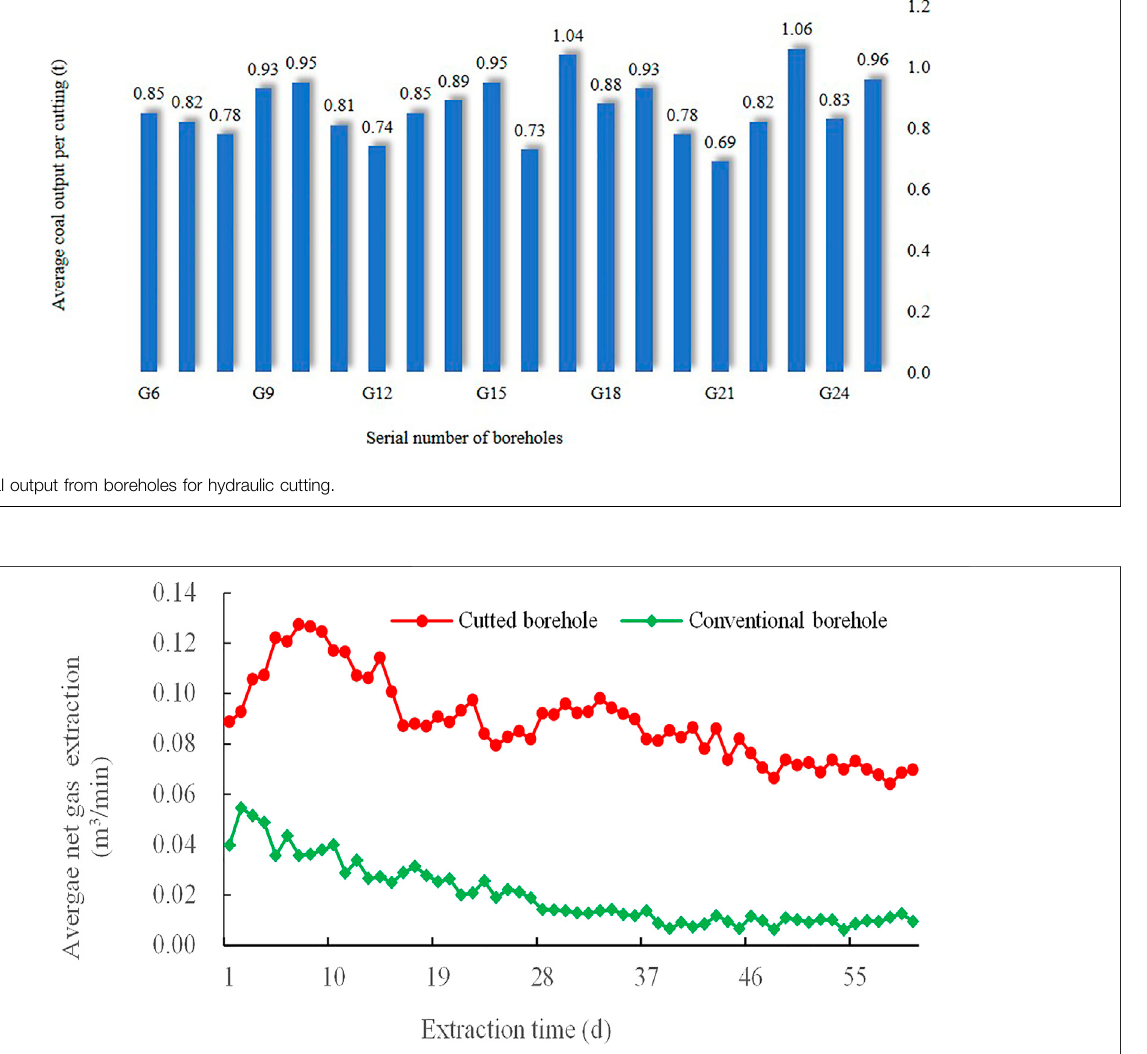
Frontiers in Earth Science |